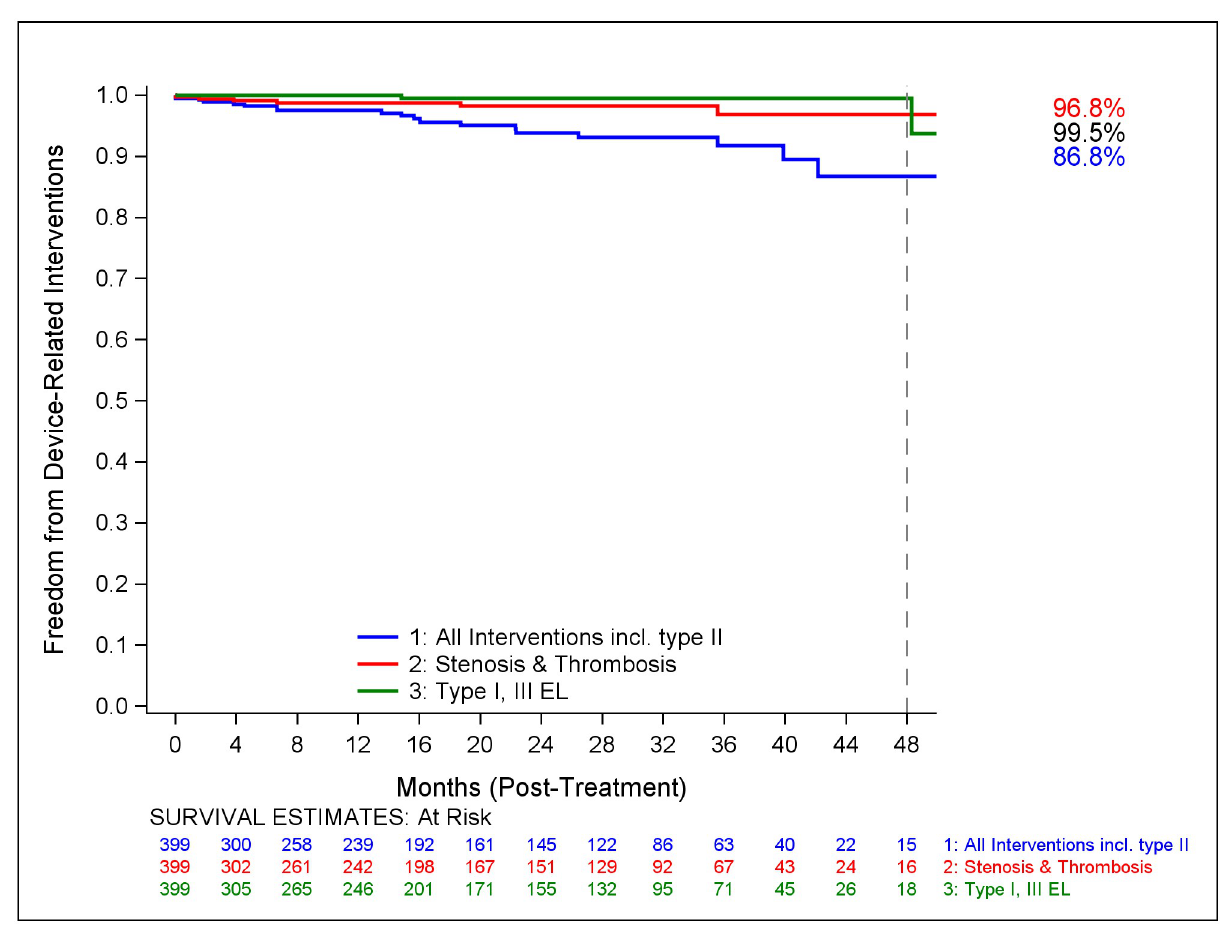
Fig 3. Freedom from AAA-related